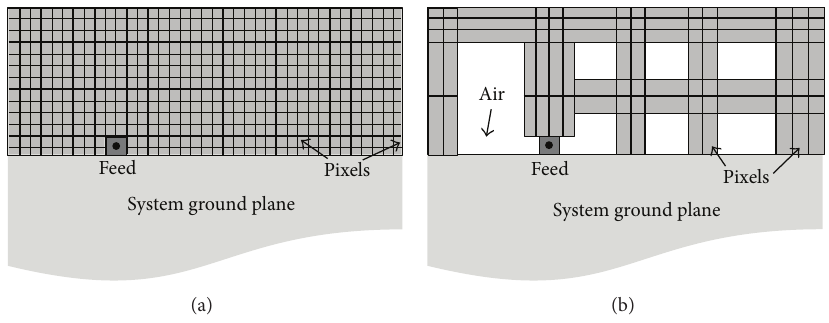
Figure 9: (a) Conventional discretization and (b) proposed nonuniform discretization of a design